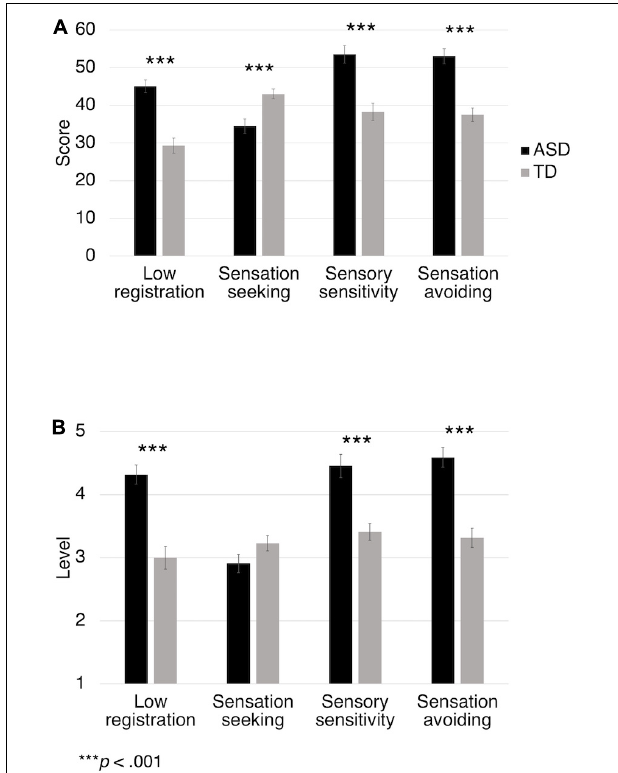
FIGURE 2 | The results of the Adolescent/Adult Sensory Profile. The raw scores are shown in (A) . The scores are classified into five levels for comparison with most people in (B) . The levels from 1 to 5 represent much less than most people, less than most people, similar to most people, more than most people, and much more than most people,